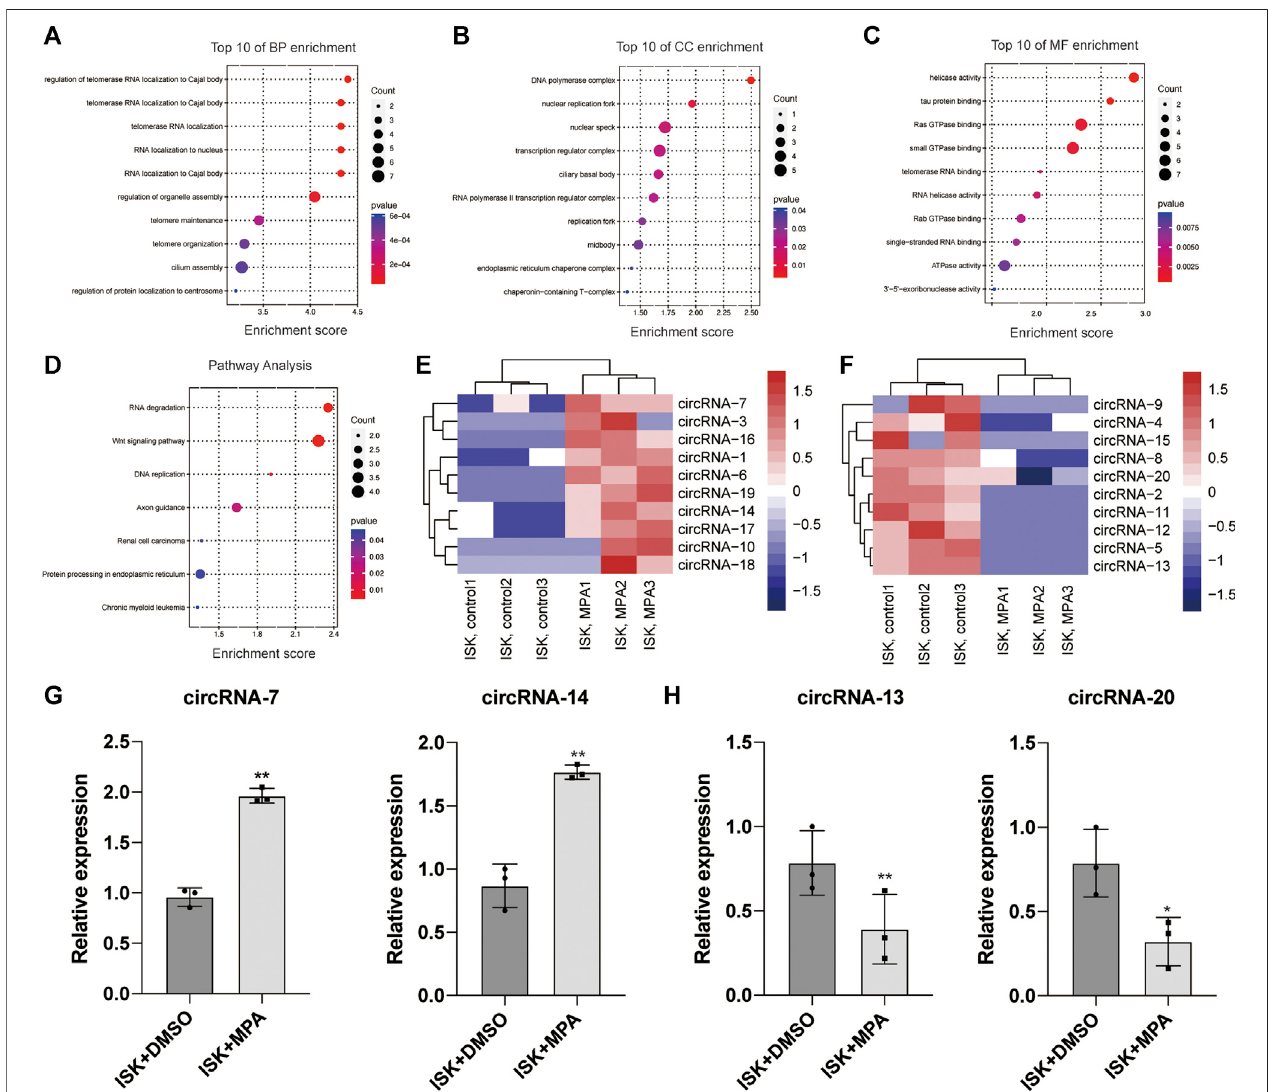
FIGURE 1 | Bioinformatic analysis of circRNA expression pattern in Ishikawa (ISK) cell lines treated with medroxyprogesterone acetate (MPA) compared with untreated. (E,F) Heat map evaluation of the circular RNA (circRNA) expression patterns among cells treated with MPA and untreated cells. Each column represents the expression pro fi le of a cell line sample, and each row corresponds to a circRNA. “ Red ” indicates higher expression level, and “ blue ” indicates lower expression level. (A – D) Biological process (BP), cellular component (CC), and molecular function (MF) terms for the parental genes of dysregulated circRNAs. (F) Kyoto Encyclopedia of Genes and Genomes (KEGG) pathways for the parental genes of dysregulated circRNAs. (G,H) Validation of the differentially expressed circRNAs by qRT-PCR assay. * p < 0.05, ** p < 0.01, *** p < 0.001.